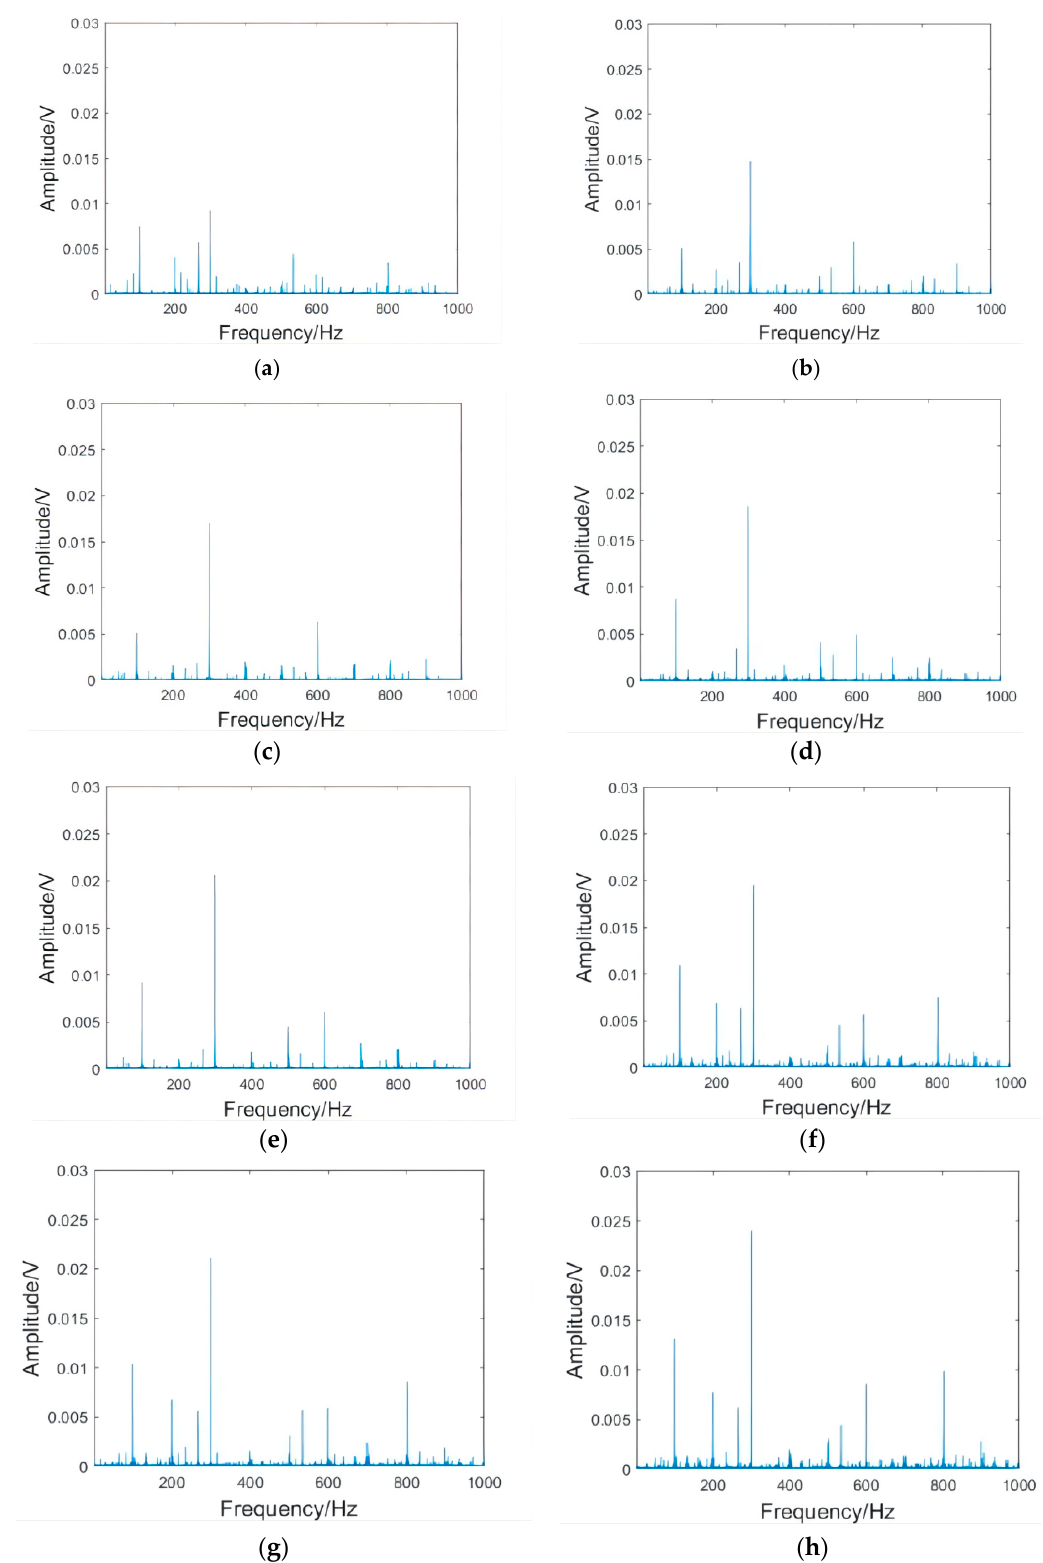
Figure 9. Vibration spectrum in the X direction of the workpiece at 8000 rpm. ( a ) After the initial clamping; and after ( b ) 1000, ( c ) 1500, ( d ) 2000, ( e ) 2500, ( f ) 3000, ( g ) 3500, and ( h ) 4000 clamping repetitions.